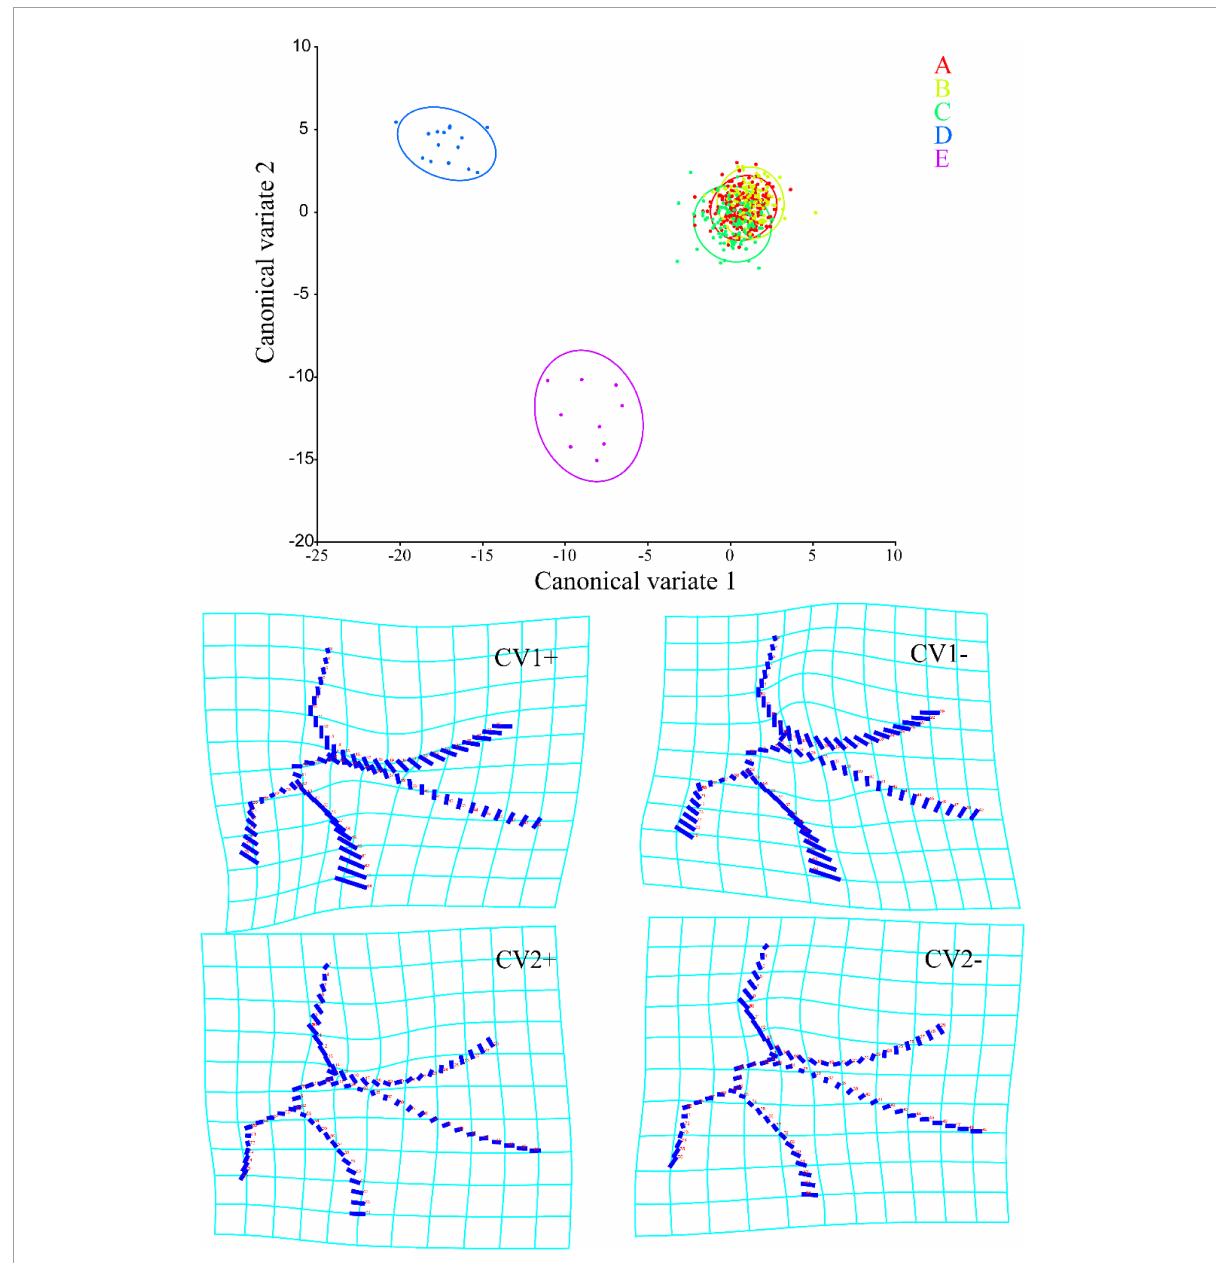
FIGURE3 Canonical variable analysis (CVA) scores and shape changes of the four tribes of Typhlocybinae: A, Typhlocybini (2 hind wing crossveins); B, Typhlocybini (3 hind wing crossveins); C, Zyginellini; D, Erythroneurini, E, Empoascini.